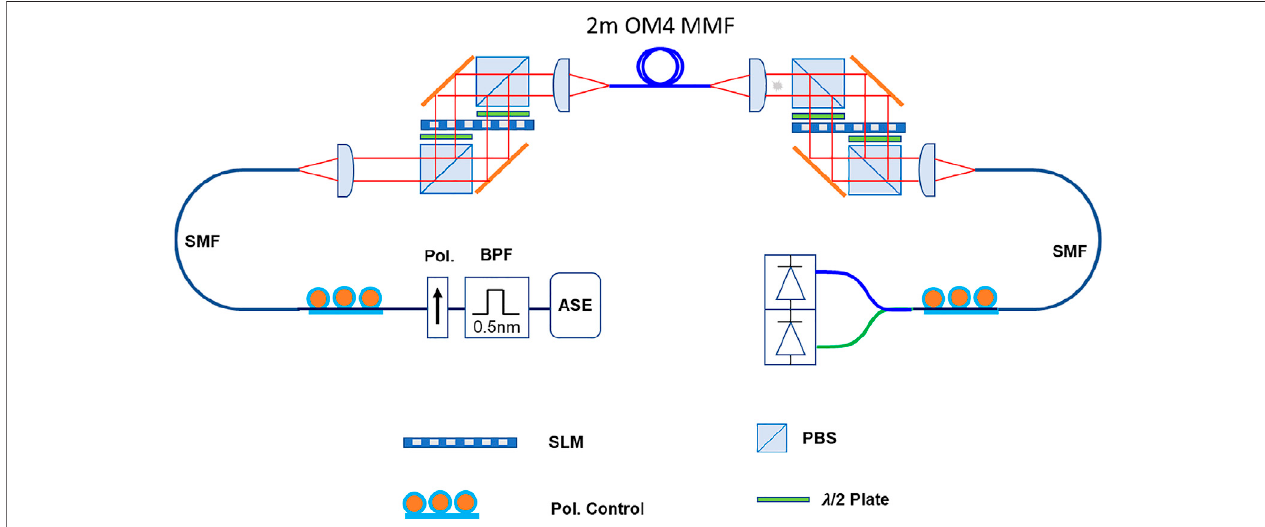
FIGURE 2 | The mode decomposition and mode generation setup proposed in